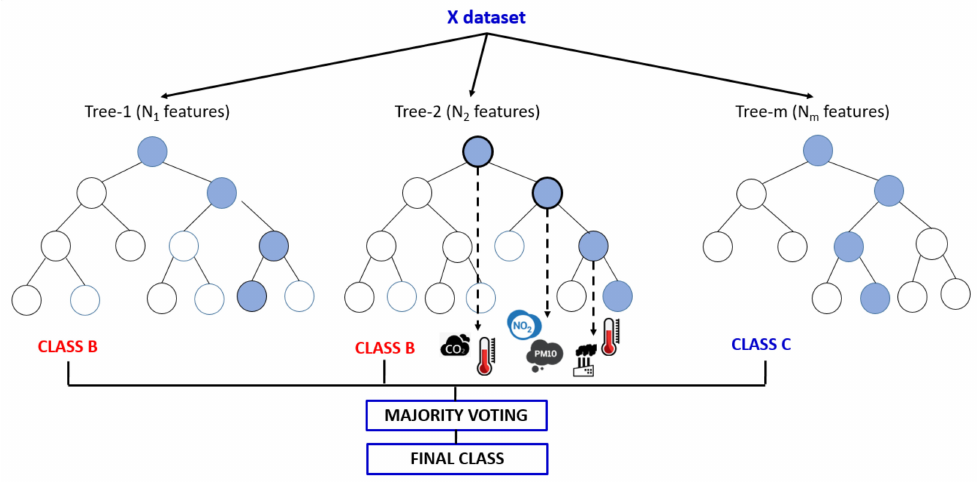
Figure 2. Illustration of a random forest